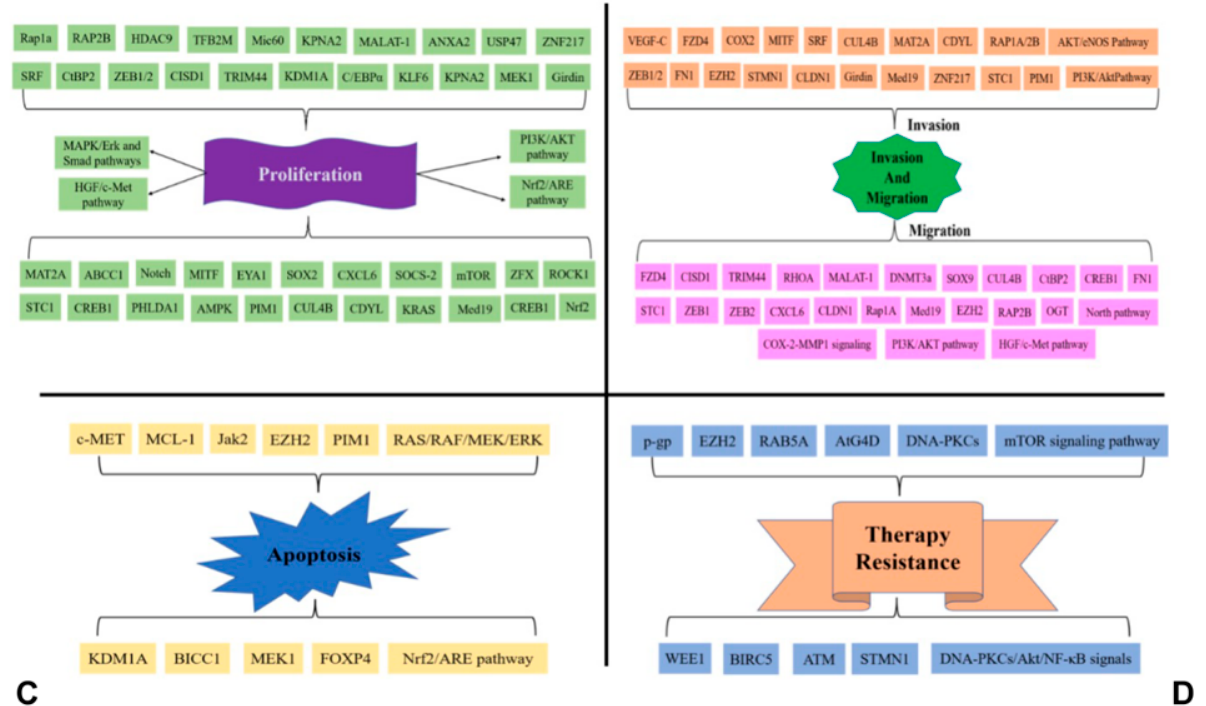
Figure 1. MiR-101 regulates proliferation, migration, invasion, apoptosis, and therapy resistance via regulates numerous targets. ( A ) MiR-101 targets important oncogenes such as SOX2 and AKT to suppress tumor growth. ( B ) MiR-101 directly targets the mRNAs encoding the ZEB1 and ZEB2 et al. in cancers; as such, when miR-101 level is reduced, the expression of ZEB1 et al. becomes elevated, which suppresses the expression of epithelial genes to promote the epithelial–mesenchymal transition (EMT) to promote cancer cell local invasion, migration, and metastatic tumors. ( C ) MiR-101 targets apoptosis-related genes MCL-1 et al. to promote cancer cell apoptosis. ( D ) MiR-101 affects therapy resistance in cancers via NF-kb signaling and other